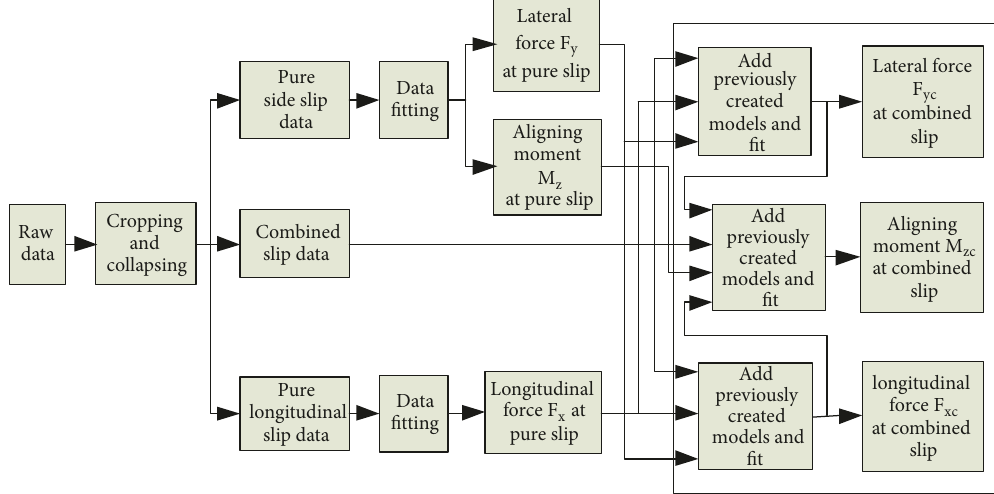
Figure 2: General idea of parameter